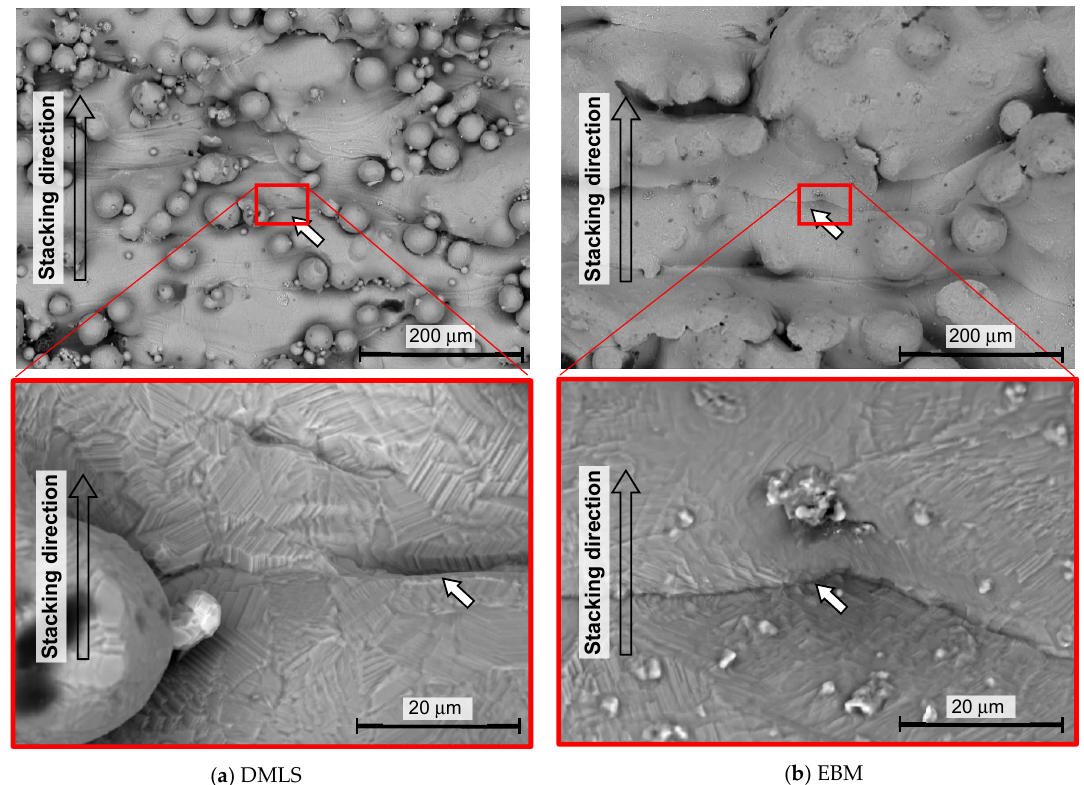
Figure A2. Schematic diagram of X-ray diffraction, considering the surface roughness and depth of the contribution to the diffracted X-ray.